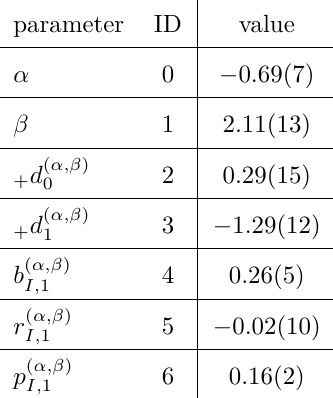
Figure 9 . The normalized covariance matrix between the parameter of the “default” model fit. The real component is on the left and the imaginary component on the right. The IDs of the parameters used on the labels are given in tables 5 and 6.